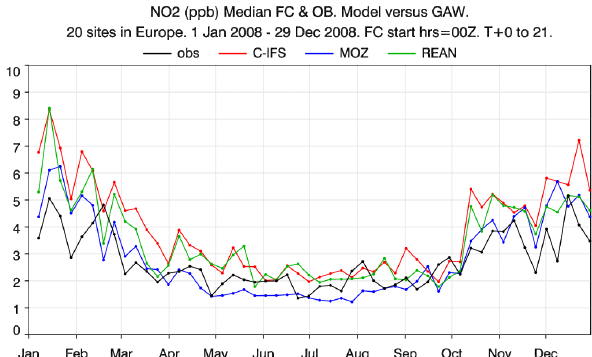
Figure 13. Time series of the median of weekly surface NO 2 vol- ume mixing ratios (ppb) in Europe (20 GAW sites) and model re- sults of C-IFS, MOZ and